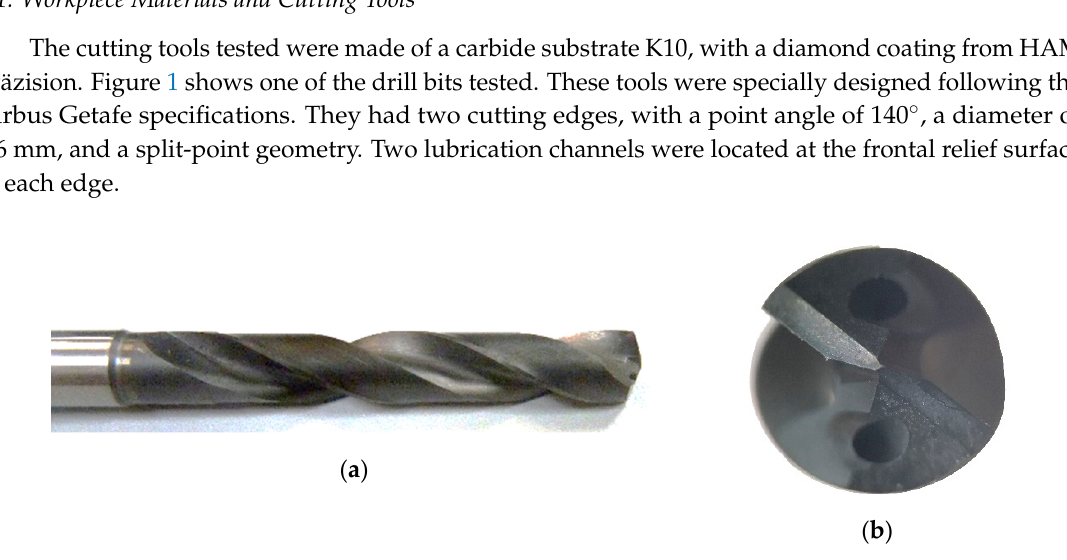
Figure 1. The diamond-coated carbide drill bit with a 7.6 mm diameter that were tested. ( a ) Lateral view. ( b ) Frontal view.